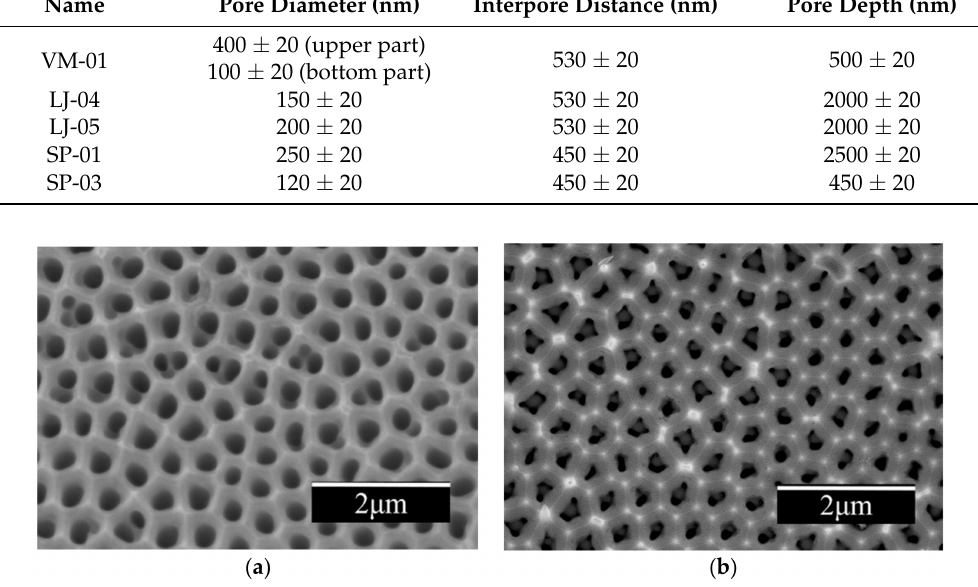
Figure 2. Scanning electron microscope (SEM) images of an AAO mold (VM-01). ( a ) Before Teflon coating; ( b ) After Teflon coating.